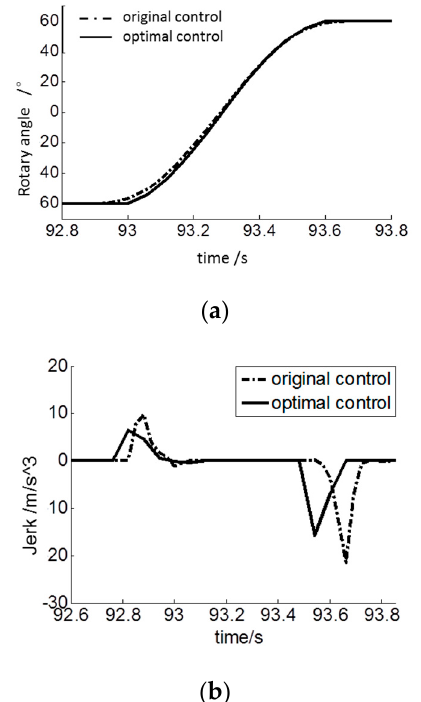
Figure 9. Performances during down-shifting. ( a ) Optimal rotary angle during down-shifting; ( b ) Jerk with different controller during down-shifting.